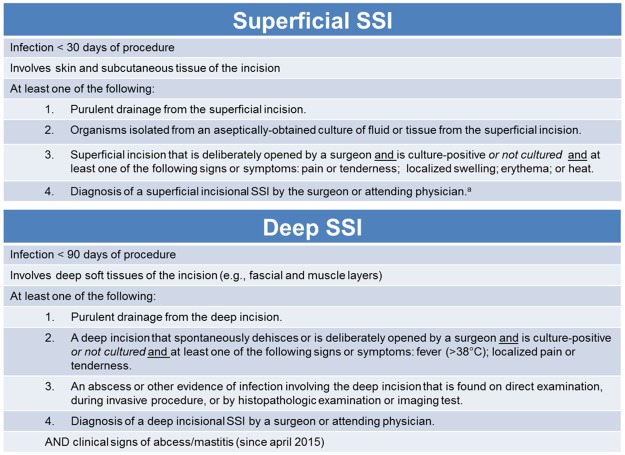
Patient flowchart (CONSORT).